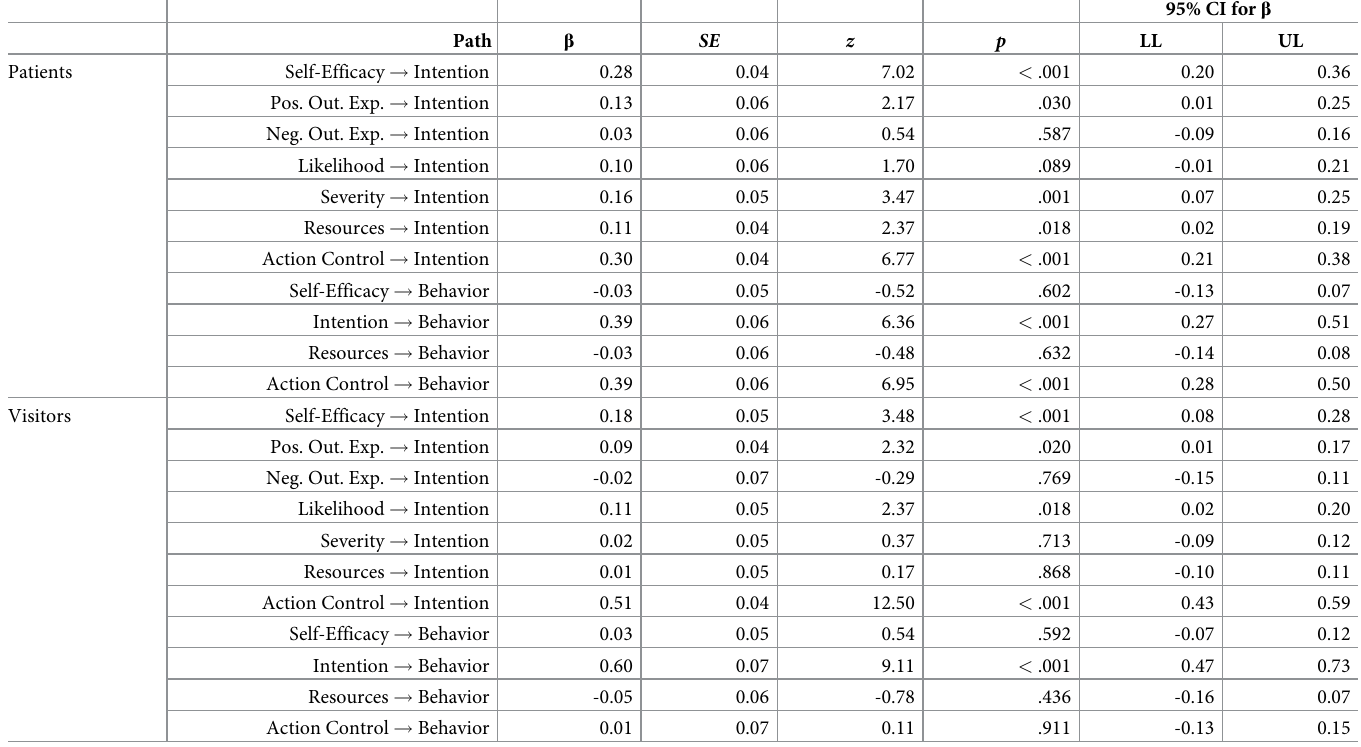
Table 2. Coefficients for the HAPA path